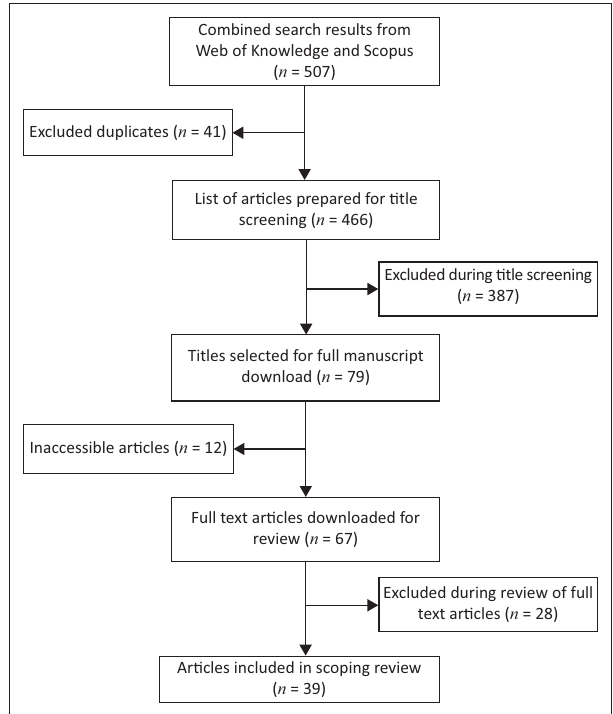
FIGURE 1: Data screening